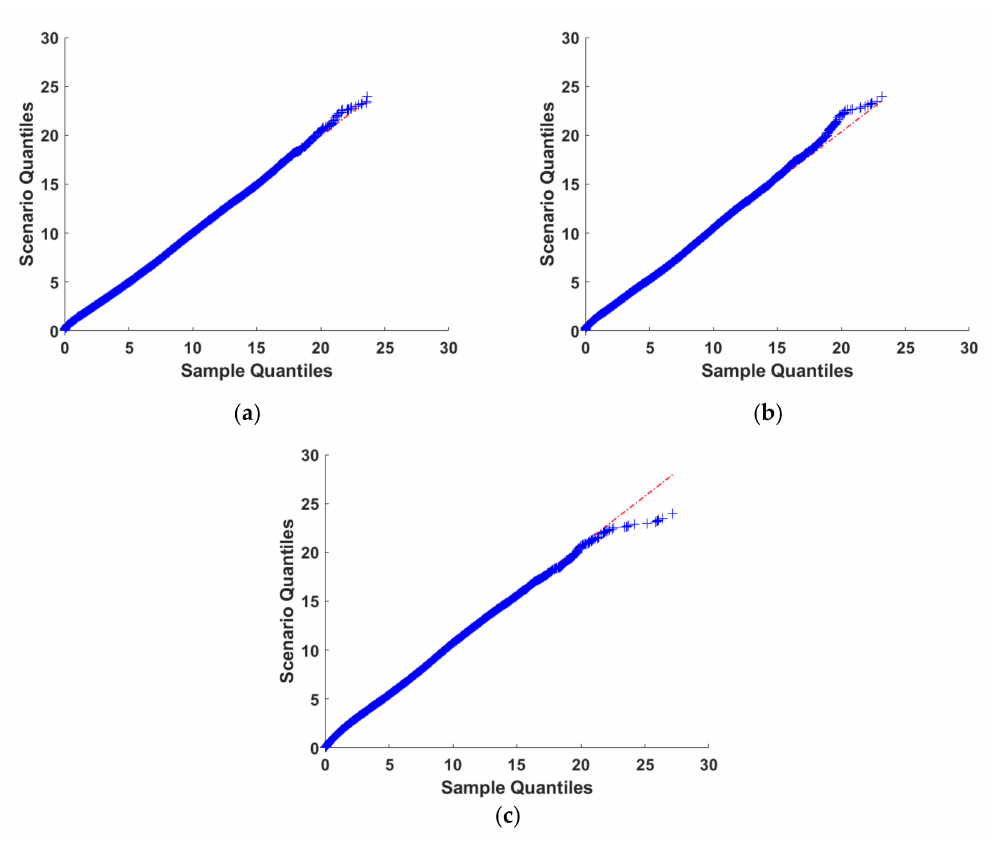
Figure 11. QQ plot for WF 3 of samples and scenarios generated using ( a ) the PC-R-vine model, ( b ) the PCA-ARMA model, ( c ) the HMCM